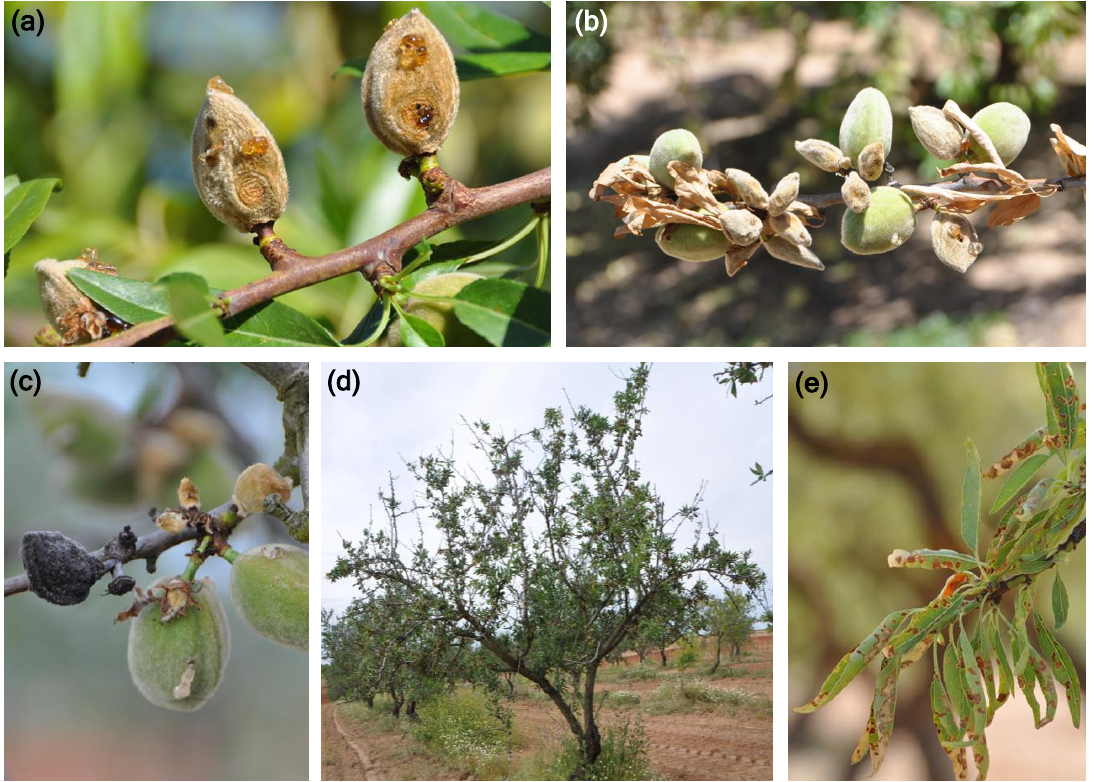
Figure 1. Characteristic symptoms of almond anthracnose caused by Colletotrichum spp. ( a ) depressed, sunken, round and orange lesions on green almonds; ( b ) branch with mummified fruits and necrotic leaves; ( c ) mummified fruits from infections caused the previous year and remaining in the tree canopy; ( d ) defoliation and dieback of shoots and branches as a consequence of the toxins produced by the pathogen; ( e ) necrotic irregular lesions in the tips and margins of the leaves